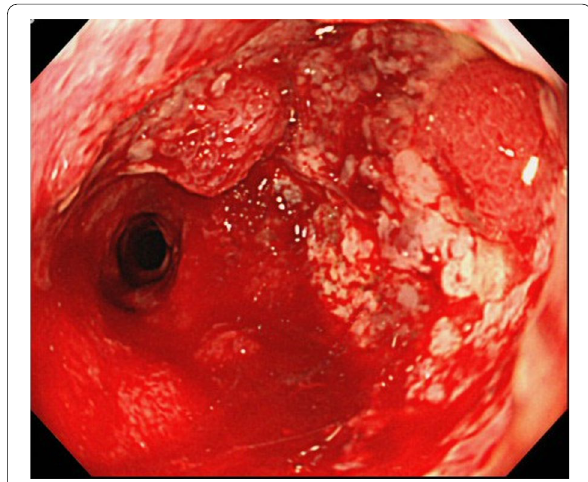
Fig. 3 Colonoscopy shows circumferential type 2 tumor located in